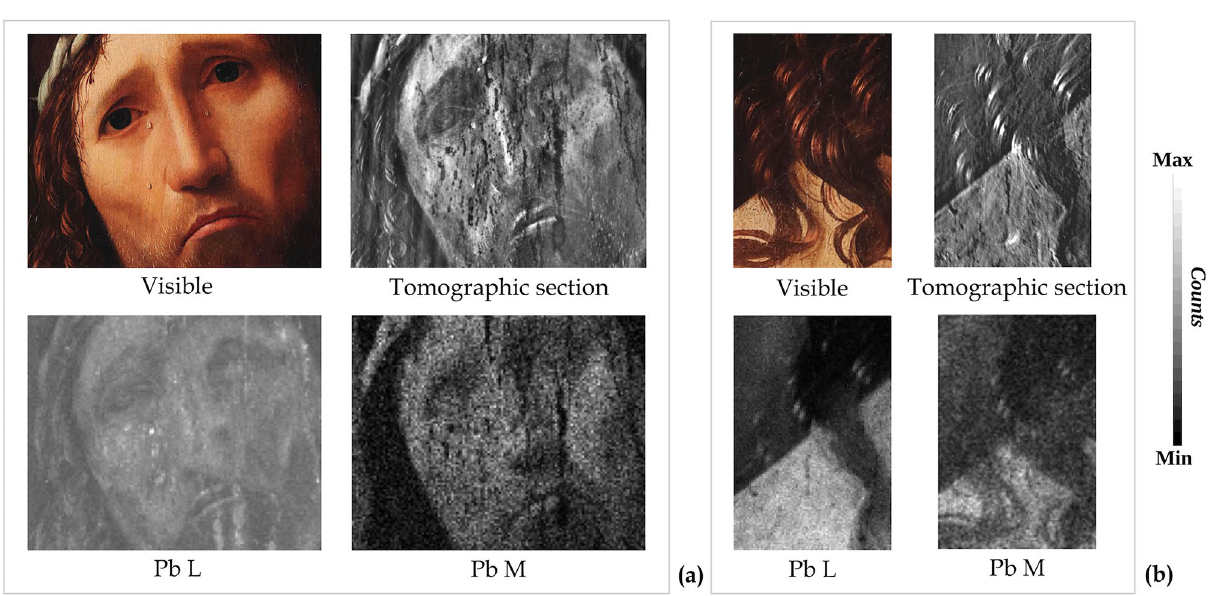
Figure 7. Analysis of the visage and right shoulder. Comparison of the visible image, tomographic section and X-ray fluorescence (MA-XRF) elemental distribution maps (Pb-L and Pb-M) of ( a ) the visage area (13 × 10.3 cm) and ( b ) the right shoulder detail (4 × 6